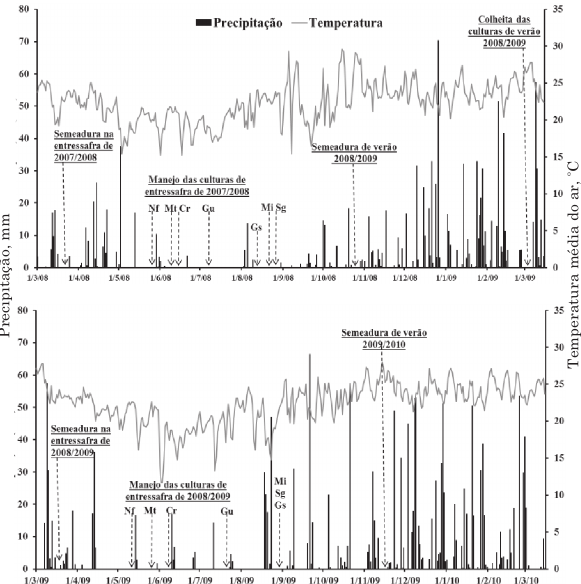
Figura 2. Valores diários de precipitação pluvial e de temperatura média do ar na área experimental no período de março de 2008 a janeiro de 2010 e os momentos de semeadura e trituração das culturas. Nf: nabo forrageiro; Mt: milheto; Cr: crotalária; Gu: guandu; Mi: milho; Sg: sorgo; Gs: